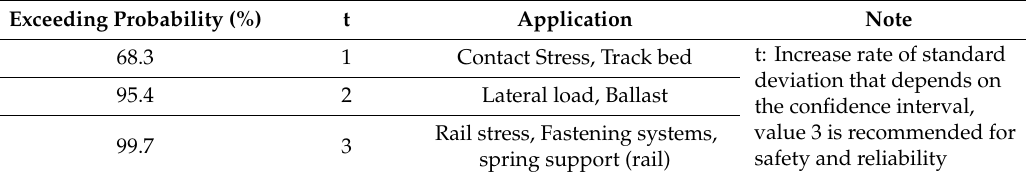
Table 2. Track exceeding probability application condition [20–23].